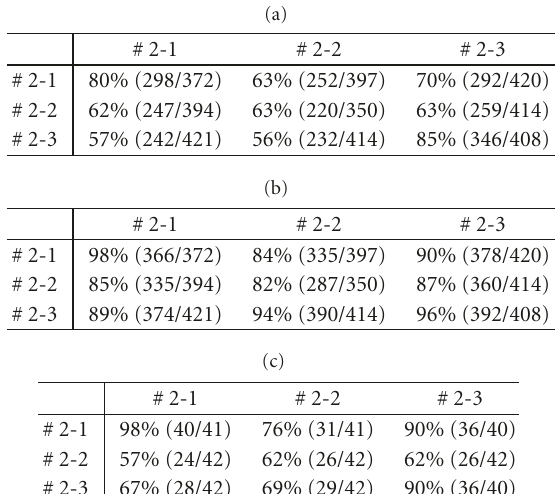
Table 4: Retrieval performance: (a) first tier, (b) second tier, (c) nearest neighbor. Query clip was generated from the sequence in the column and the clips from the sequences shown in the row were used as candidates. The query itself was not included in the candi- date